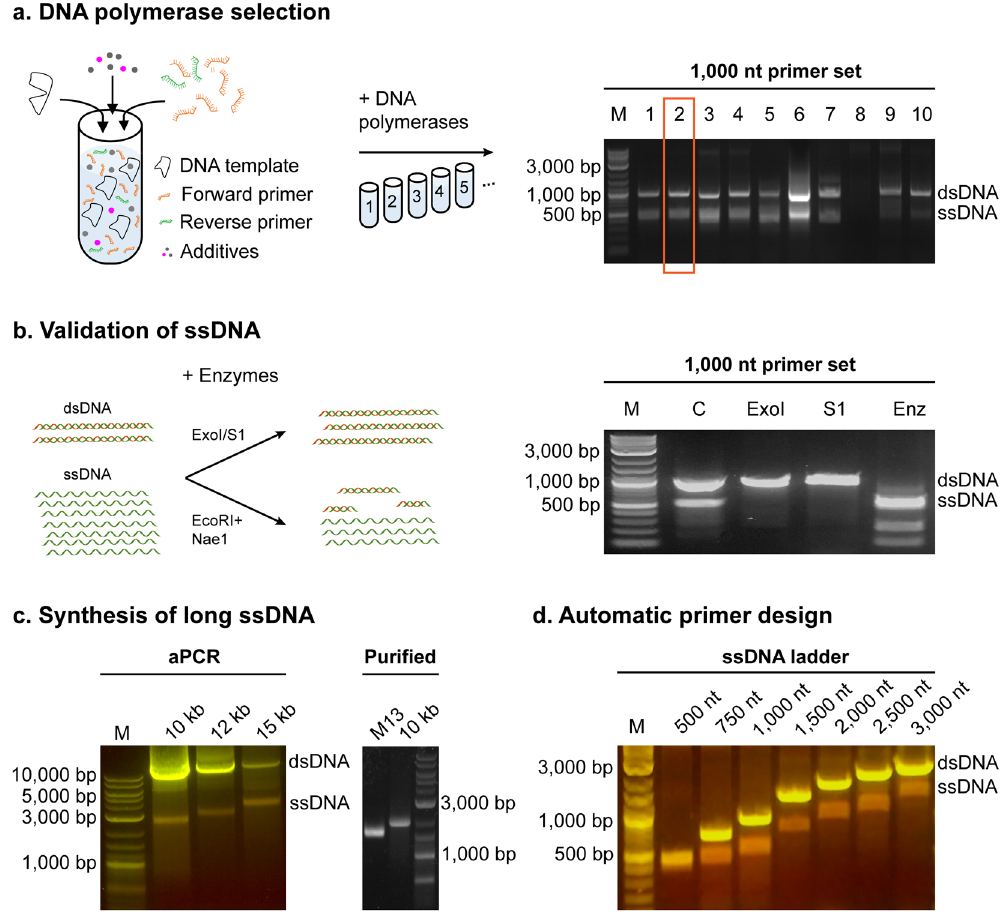
Figure 1. ssDNA production by aPCR. ( a ) aPCR reactions were assembled with a 50-molar excess of a forward primer for the amplification of a 1,000 nt ssDNA fragment using the M13mp18 ssDNA plasmid as template, and with 10 different polymerases that were tested for highest yield of ssDNA production (upper band: expected dsDNA size is 1,000 bp; lower band: expected ssDNA size is 1,000 nt) as judged by agarose gel electrophoresis (right panel). QuantaBio AccuStart HiFi, polymerase (lane 2, boxed) produced the highest amount without overlapping dsDNA contaminants. 1. Accustart; 2. Accustart HiFi; 3. Accustart II; 4. AccuPrime; 5. GoTaq; 6. DreamTaq; 7. Phusion; 8. Platinum SuperFi; 9. Q5; 10. Tth polymerase. ( b ) Biochemical validation of ssDNA production by incubating 1,000 nt aPCR reaction products with the ssDNA-specific ExoI or S1 nucleases or dsDNA-specific restriction enzymes Eco RI and Nae I (left panel). Agarose gel electrophoresis of the digestion products as labeled by lane (right panel). M: Marker, C: aPCR product control, ExoI: exonuclease I, S1: S1 nuclease, Enz: Eco RI + Nae I. ( c ) NEB LongAmp was used to generate ssDNA up to 15,000 nt long using lambda phage dsDNA as template. Purification of the 10 kb fragment shows a single band of higher molecular weight than the M13mp18 ssDNA (7,249 nt). ( d ) The primer design algorithm aPrime was used to select primers for product sizes between 500 and 3,000 nt using M13mp18 ssDNA as template and the Quantabio Accustart HiFi enzyme. SYBR Safe stained agarose gels illuminated under blue light show dsDNA as yellow bands, while ssDNA show as orange